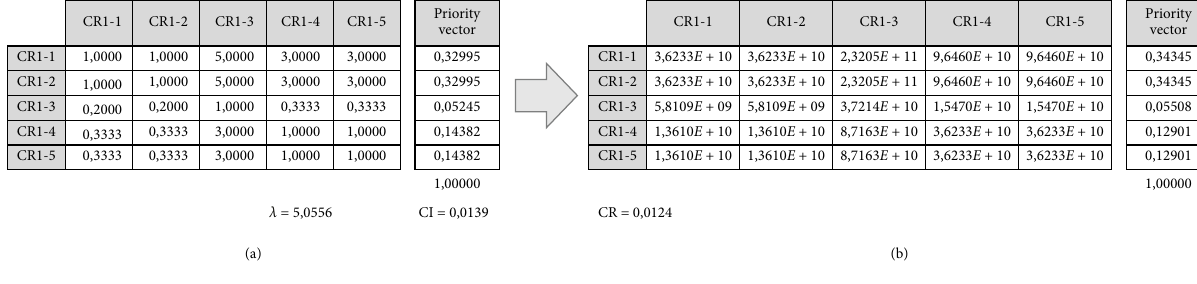
Figure 2: Matrices of priorities for CR1